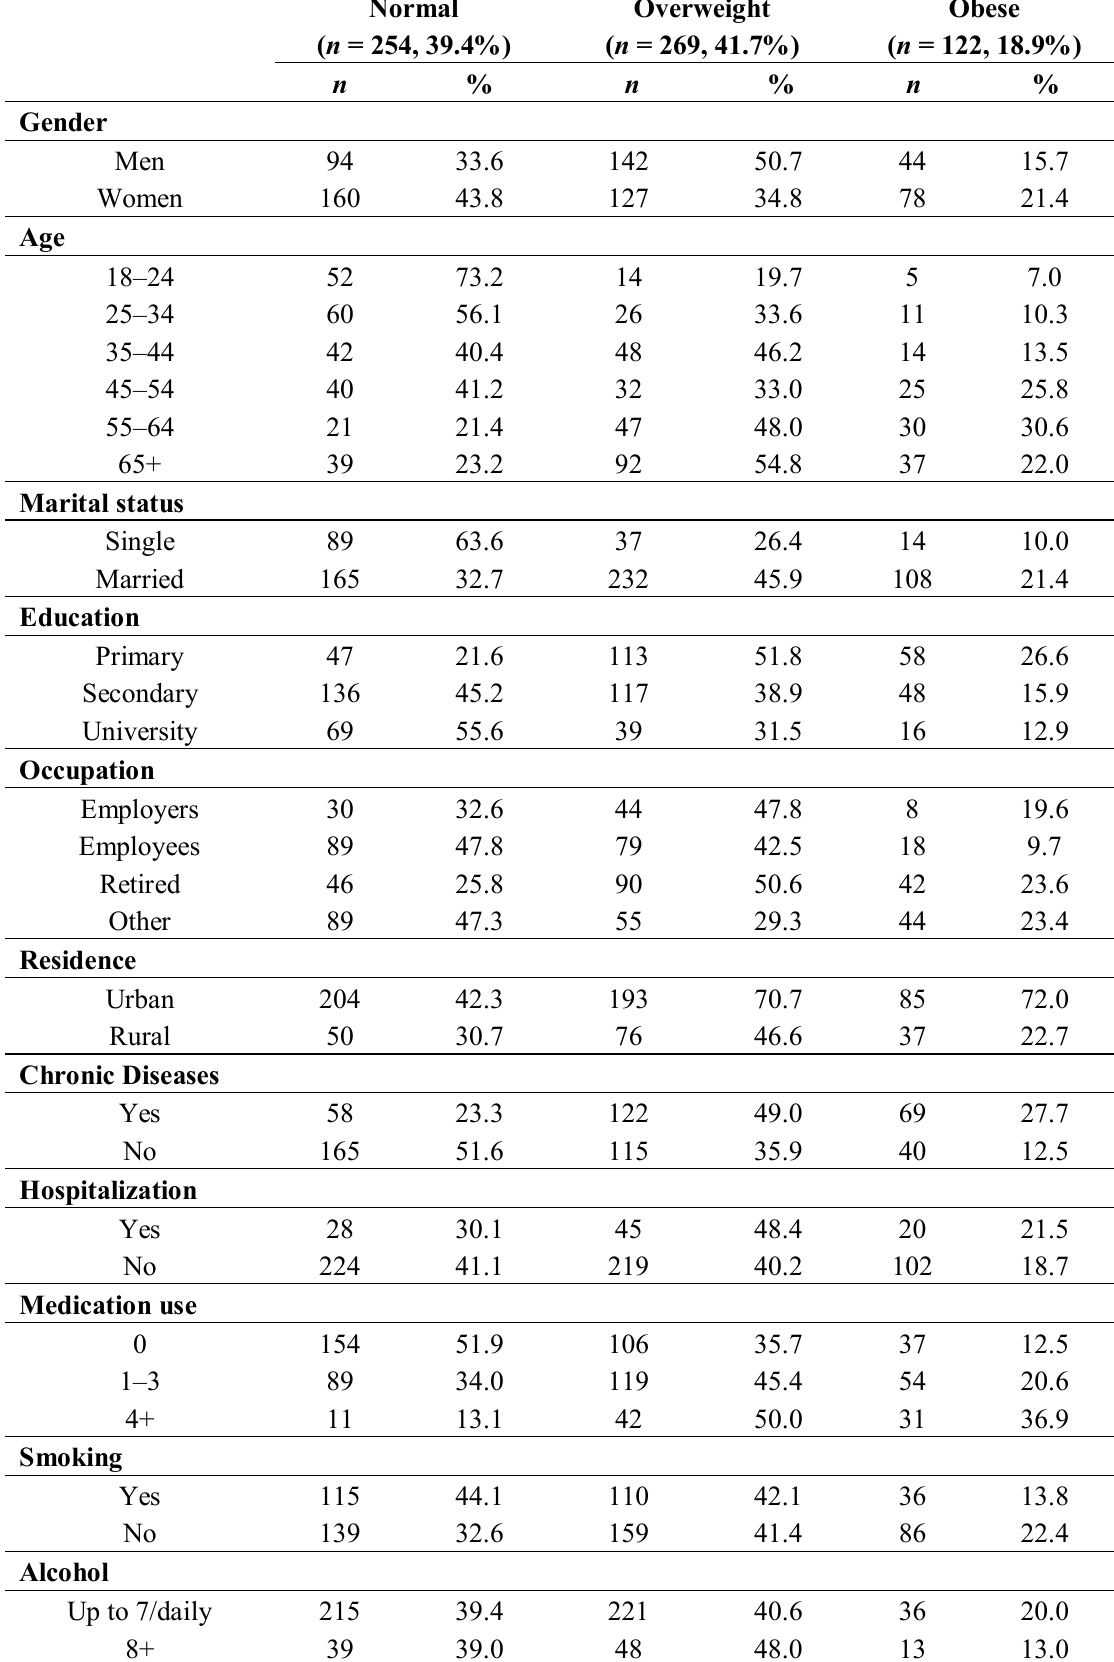
Table 1. Socio-demographic distribution of the sample according to BMI categories.